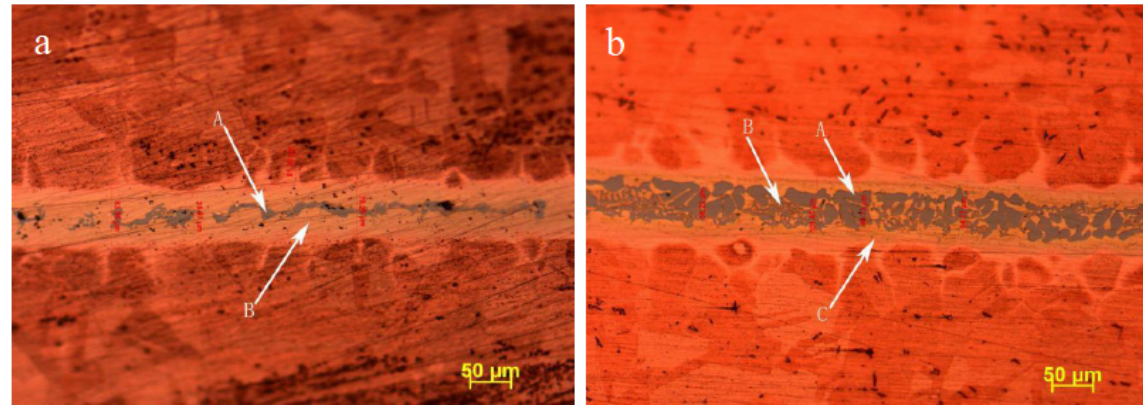
Figure 7: Microstructure of the brazed joints with the (a) amorphous and (b) crystalline filler metal at the brazing temperature of 650 ∘ C